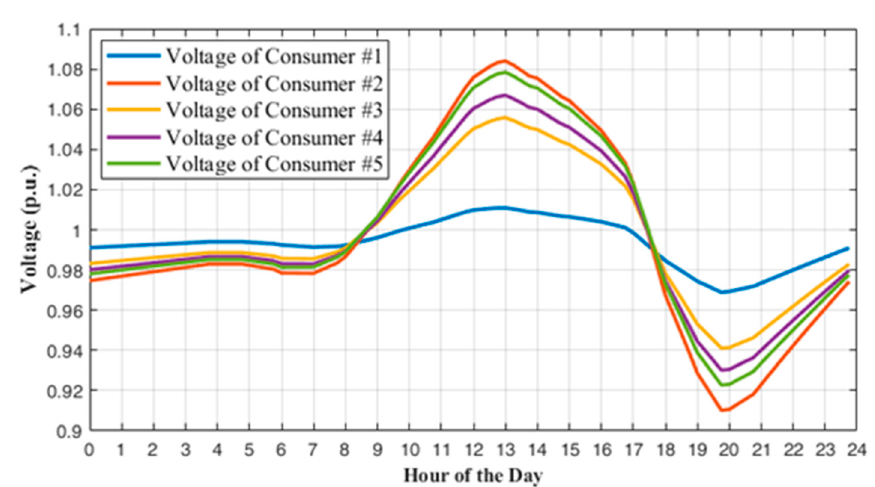
Figure 13. Voltage profile at consumer premises without the centralized voltage controller